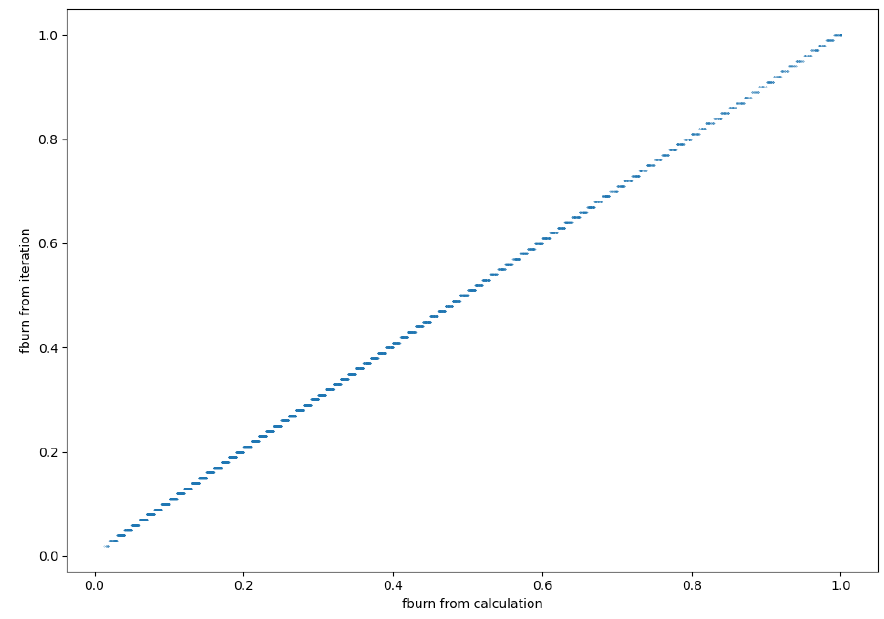
Figure A1. Model outputs tested with both iteration and direct